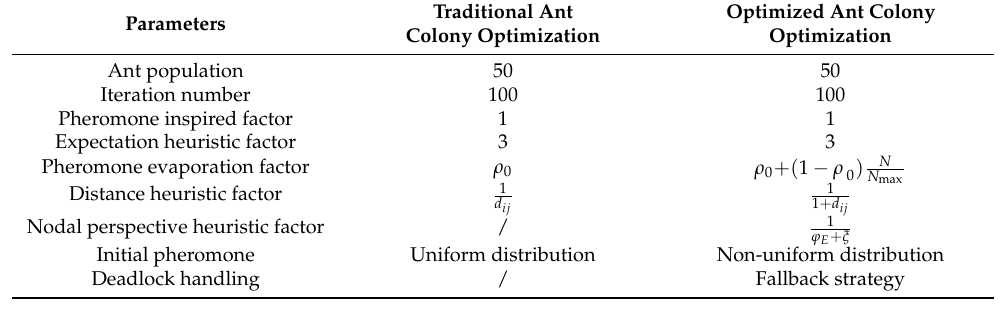
Table 3. Comparison of algorithm parameter settings.